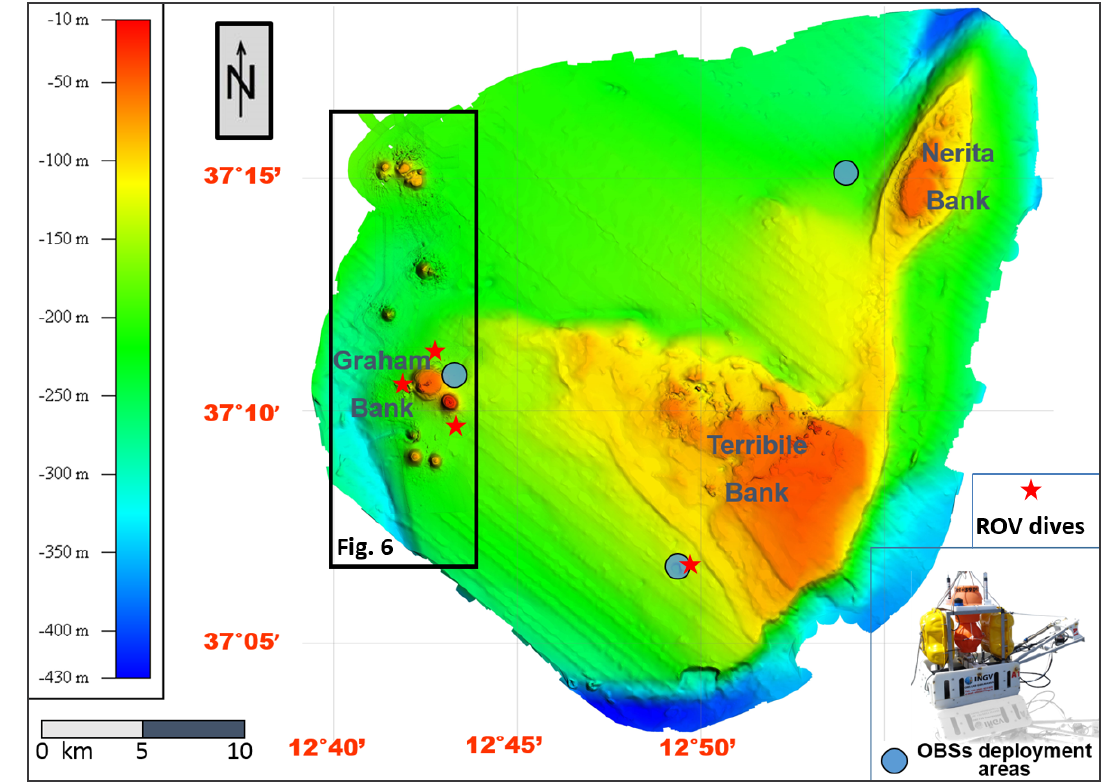
Figure 4. Bathymetric map of the three banks located offshore the southwestern coast of Sicily (the bathymetric data of the Nerita and Ter- ribile banks have been provided by the Istituto Idrografico della Marina Italiana), with location of the OBS/Hs deployment areas and ROV dives. The black box represents the area of Figure